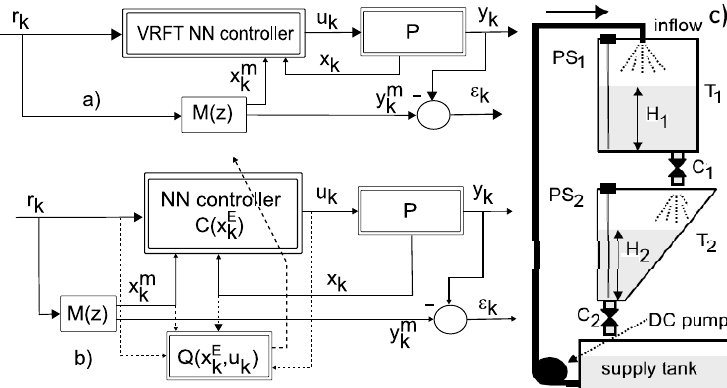
Figure 1. ( a ) control system with the VRFT controller; ( b ) control system with the VRFT NN controller further tuned by AAC design in a deep learning architecture; ( c ) the vertical tank system